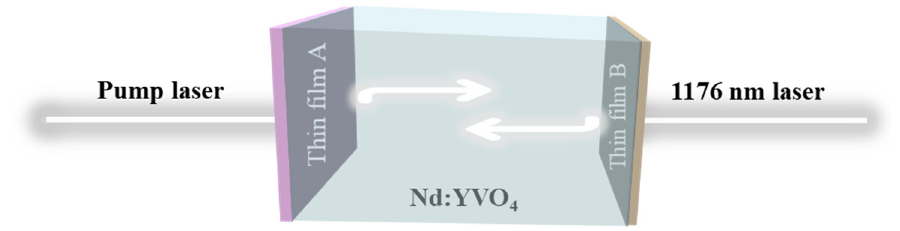
Figure 2. Working diagram of Nd:YVO 4 crystal device generating self-Raman 1176 nm laser. Table 1. Technical parameters of resonant cavity film based on Nd:YVO 4 crystal for self-Raman 1176 nm laser generation.